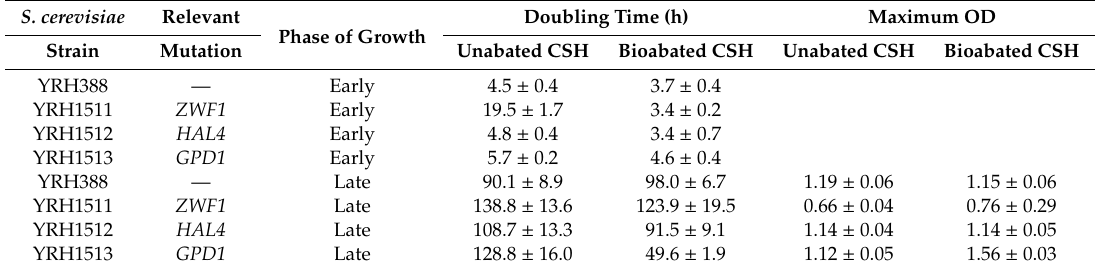
Table 3. E ff ect of bioabatement on growth of YRH388 isogenic mutants in corn stover